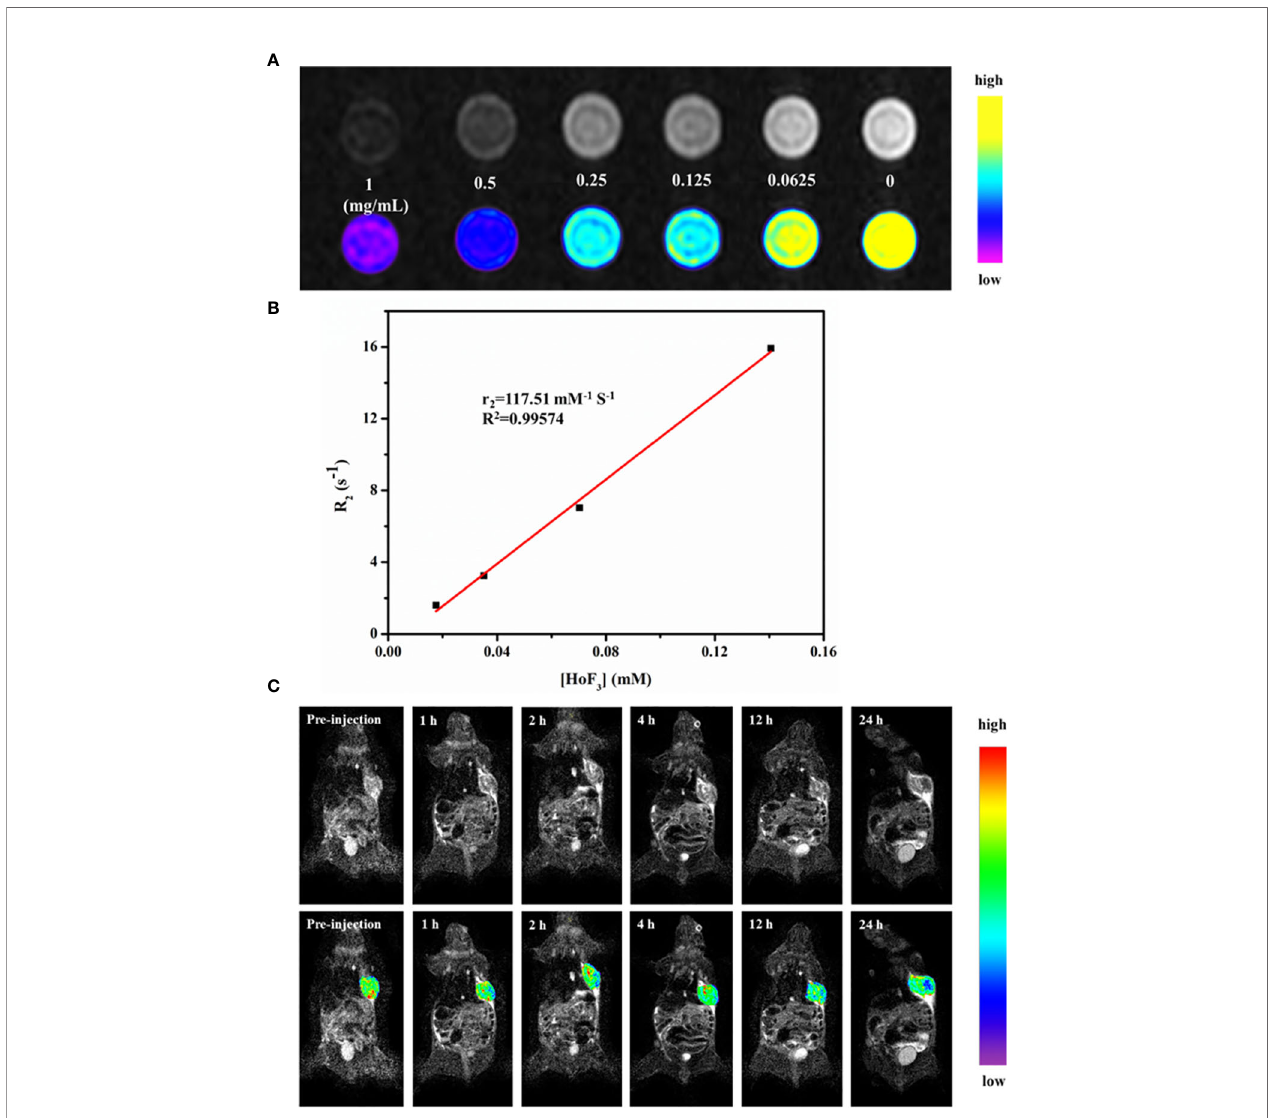
FIGURE 7 | (A) In vitro T 2 -weighted MRI images of PEG-HoF 3 NPs with different concentration; (B) The r 2 relaxivity plot of PEG-HoF 3 NPs; (C) Signal changes of tumor site in different time point before and post-injection of PEG-HoF 3